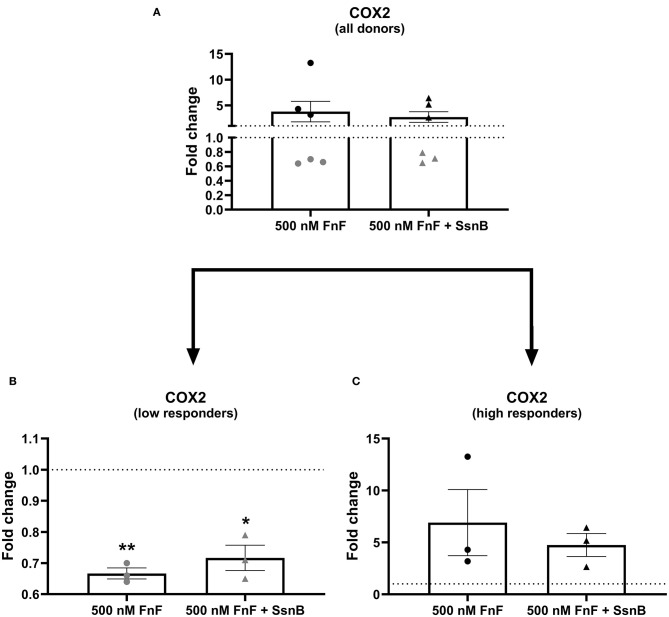
Gene expression of COX-2 after 18 h exposure to 30 kDa fibronectin fragments (500 nM) alone and in combination with the TRL-2/TRL-4 inhibitor Sparstolonin B. All donors (A) and split according to low responders (B) and high responders (C). mRNA was quantified by real time RT-qPCR (RT-qPCR). Values of COX-2 were normalized to the reference gene (GAPDH) and presented as the fold change compared to untreated control (FnF stimulation alone) or NP cells treated with Sparstolonin B alone. *Denotes statistically significant differences with p < 0.05. Due to significant donor variation, low and high responders are displayed in a separate graph (B,C). Points demonstrate NP cells treated with 500 nM 30 kDa FnF. Triangles demonstrate NP cells treated with a combination of FnF and Sparstolonin B. The color black indicates high responders and the color gray indicates low responders. *Denotes statistically significant differences with p < 0.05 and **p < 0.01.